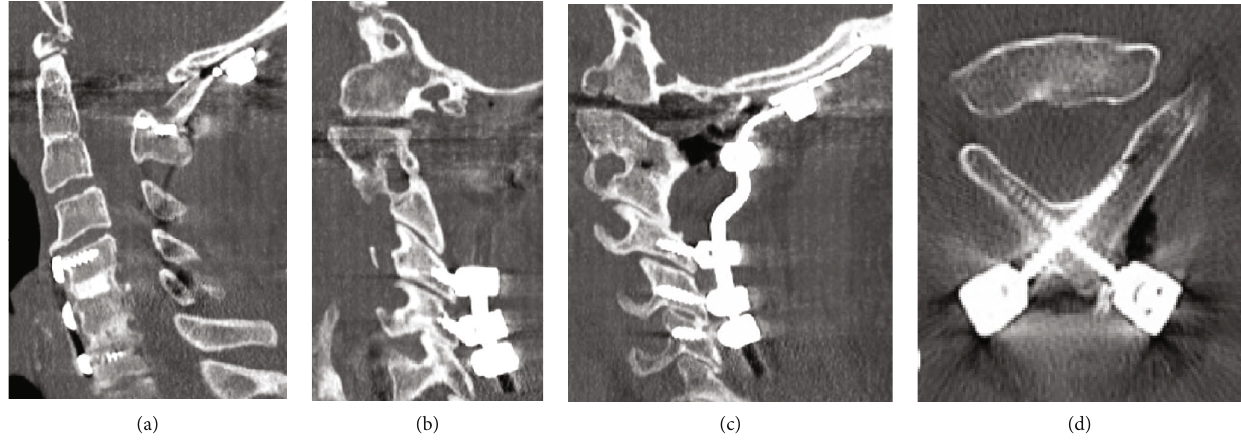
Figure 3: Case 1: postoperative CT. (a) The reduction of the cortical step-o ff between the anterior arch of C1 and the clivus with partial reduction of the odontoid. (b) Right and (c) left. C1 screws were not placed. The vertebral arteries course bilaterally below the C1 ring. Lateral mass screw placed bilaterally at C4, C5, and C6. (d) Fixation to C2-C3 vertebrae block was obtained by placing laminar screws bilaterally at